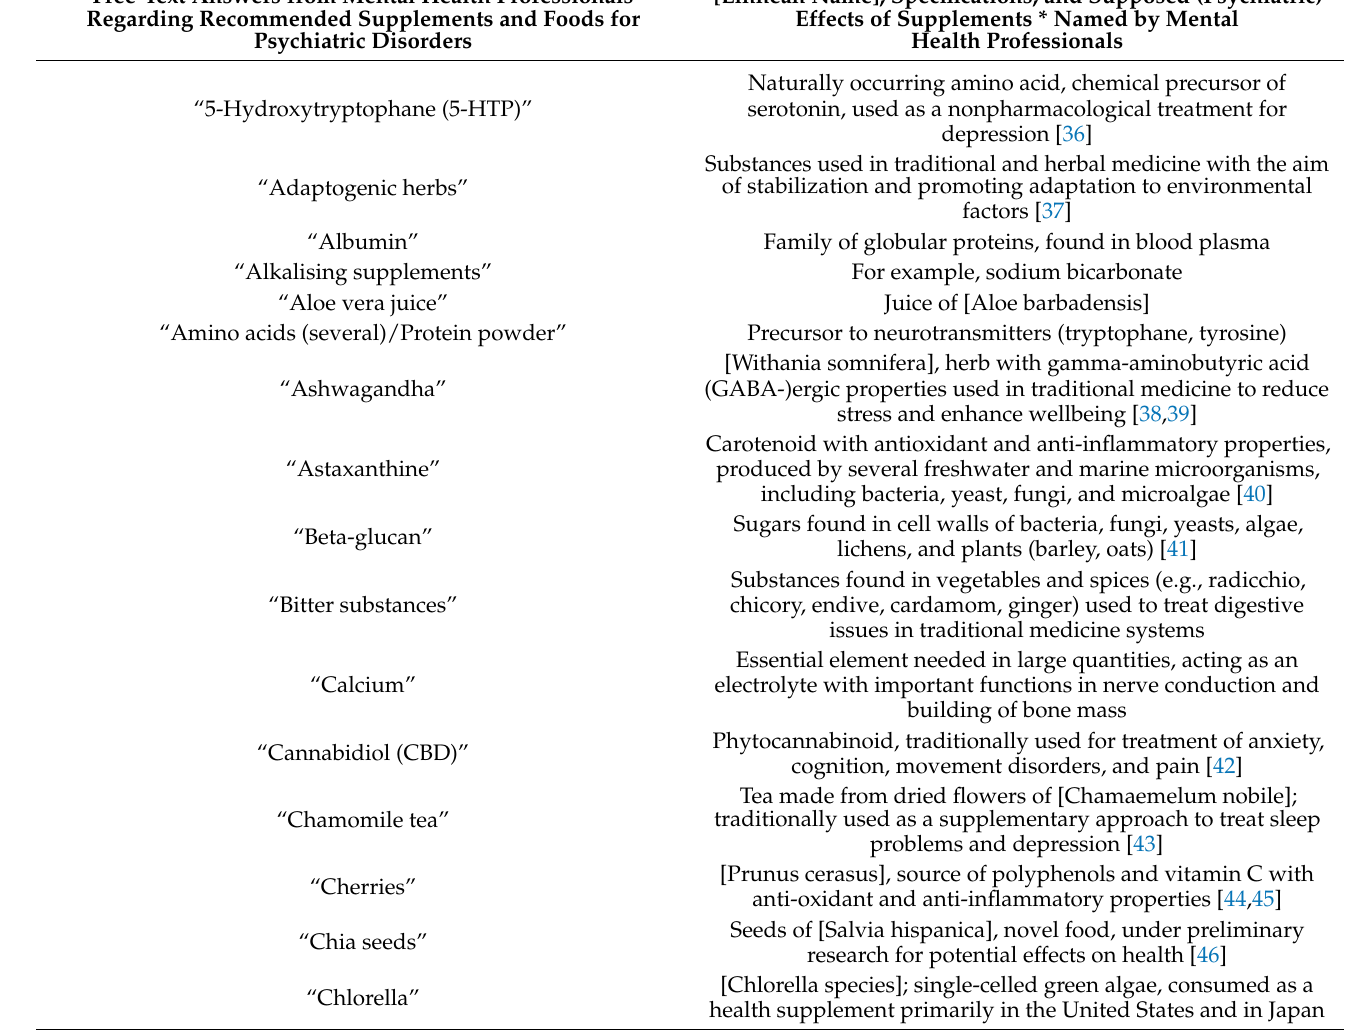
Table 5. List of answers in a free text field regarding previous recommendation of any other supplements which were not listed in the options of the questionnaire. Free-Text Answers from Mental Health Professionals Regarding Recommended Supplements and Foods